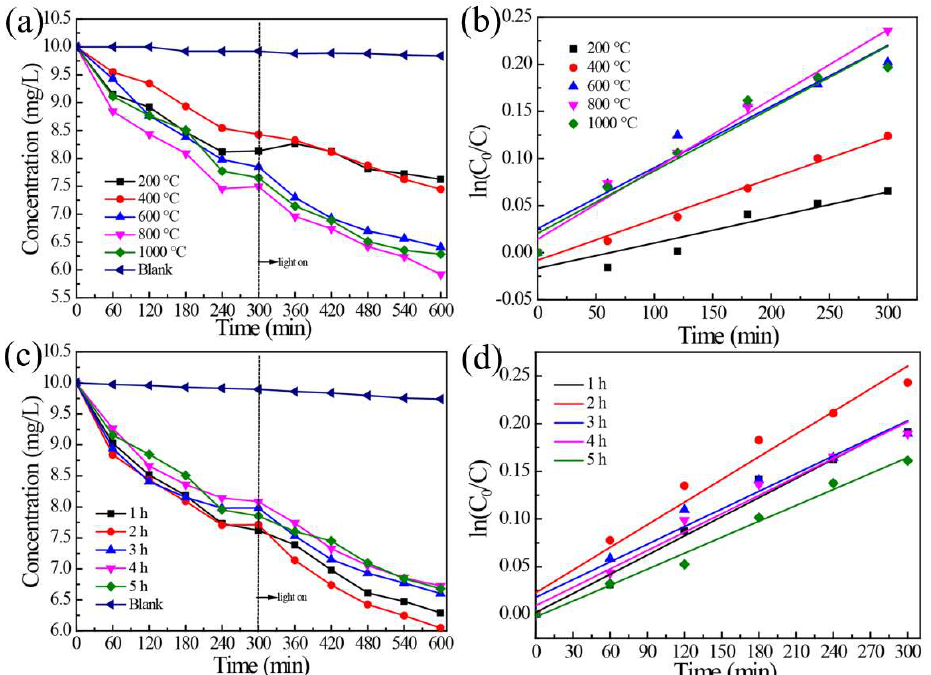
Figure 7. ( a ) Ammonia-nitrogen removal performance of HAP samples prepared at different calcination temperatures; ( b ) fitting curve of first-order kinetics of photocatalytic degradation of HAP samples obtained at different calcination temperatures; ( c ) performance diagram of removing ammonia-nitrogen from water by HAP sample; ( d ) fitting curve of first-order kinetics of photocatalytic degradation of HAP samples prepared under different calcination time.